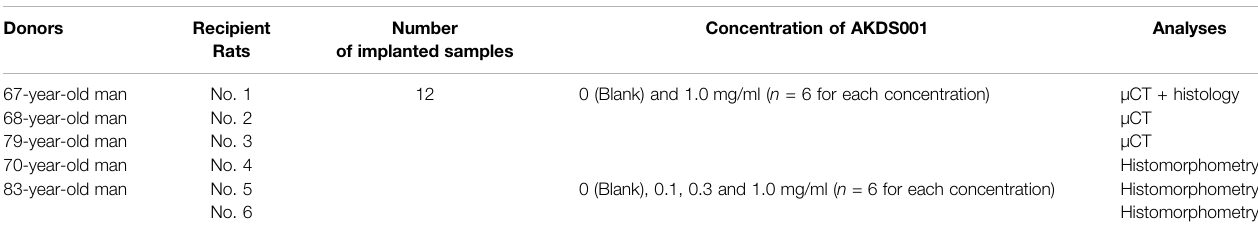
TABLE 1 | Detailed information about the xenotransplantation of human vertebral bone.